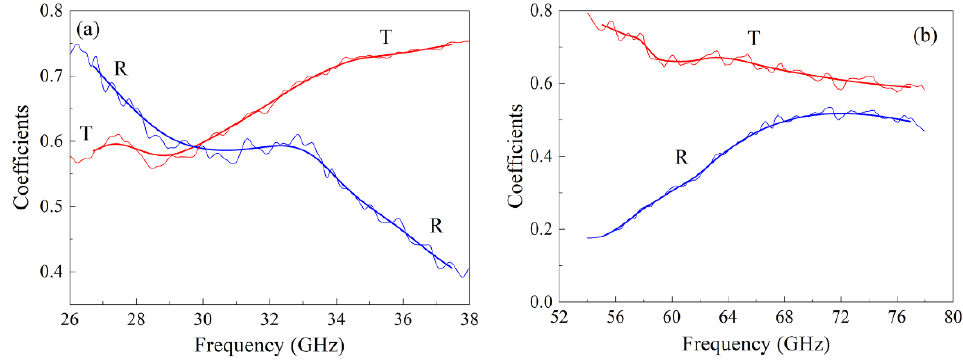
Figure 5. Frequency dependences of transmission and reflection coefficients for a composite with 3.8% flakes and 2% CNT in the frequency range from 26 to 38 GHz ( a ); in the frequency range from 53 to 78 GHz ( b ).